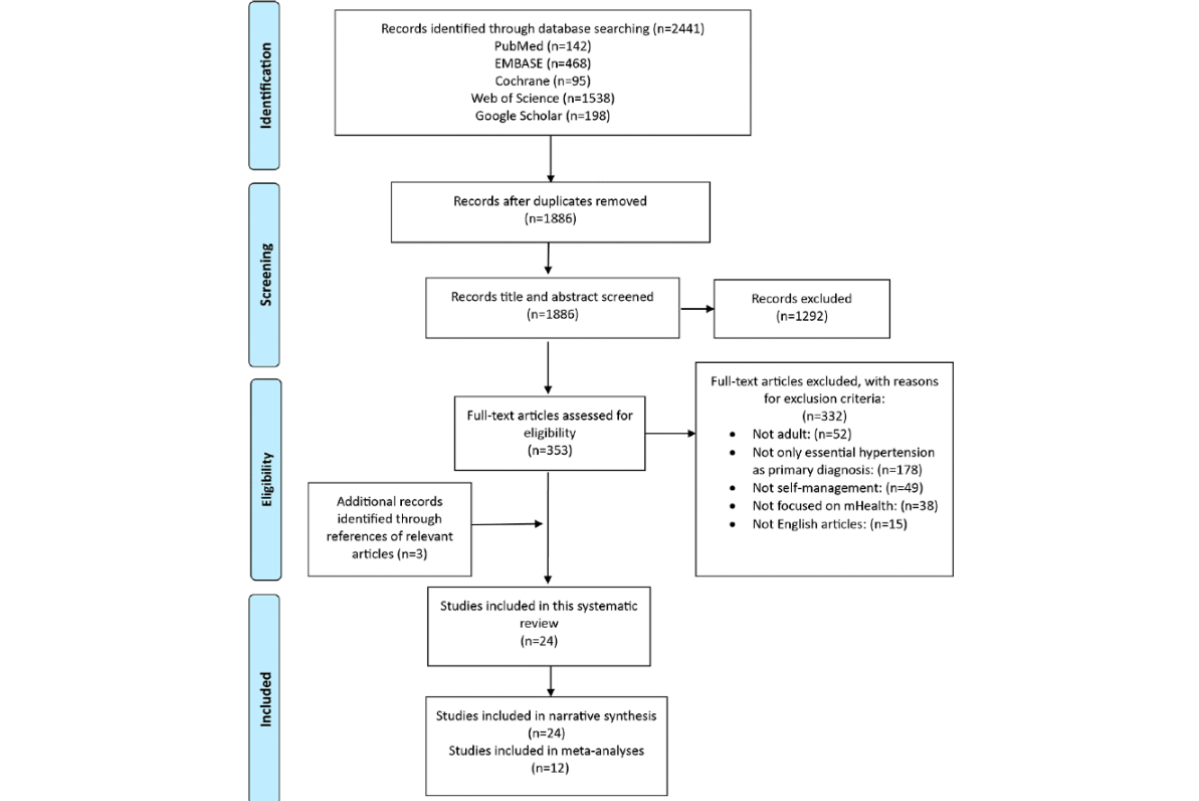
Figure 1. Flow diagram of study selection. mHealth: mobile